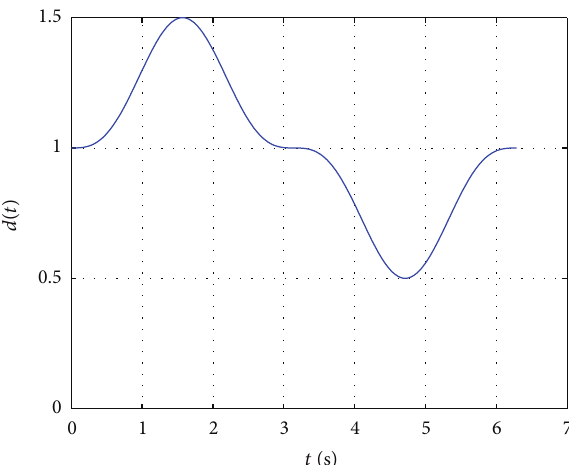
Figure 2: Interval time-varying delay 𝑑(𝑡) of Example 1.